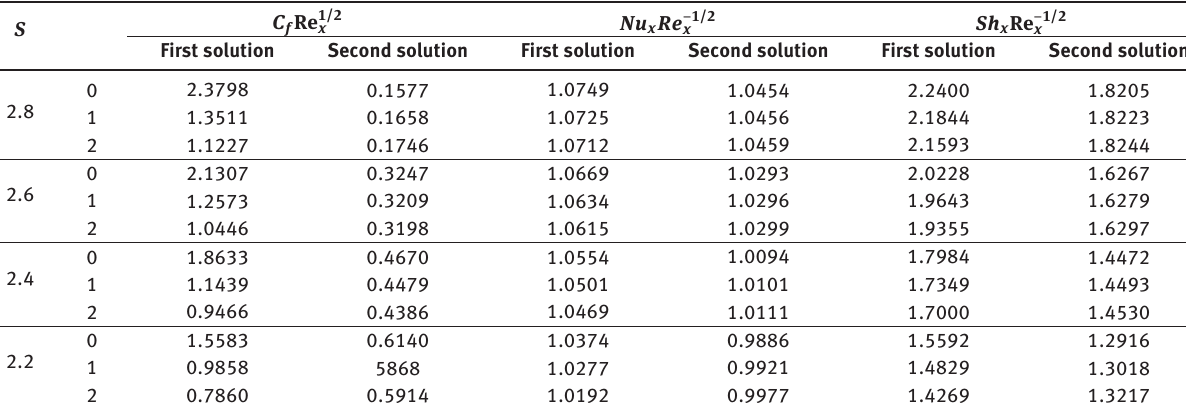
Table 2: Values of skin friction, Nusselt number and Sherwood number for different values of K when Nb = 1, Nt = 1.5, Le = 1, Q w = 1.5, R d = 2, γ = 0.3 are fixed.